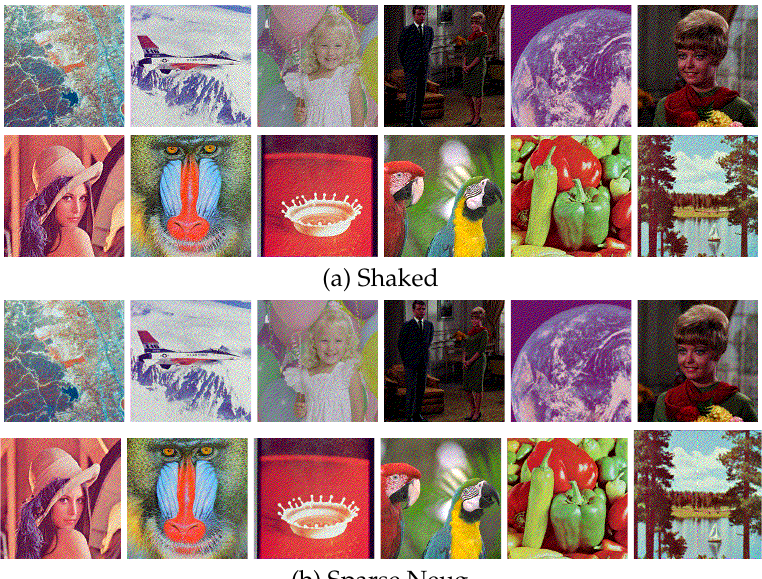
Figure 15. Halftoned SIDBA images.